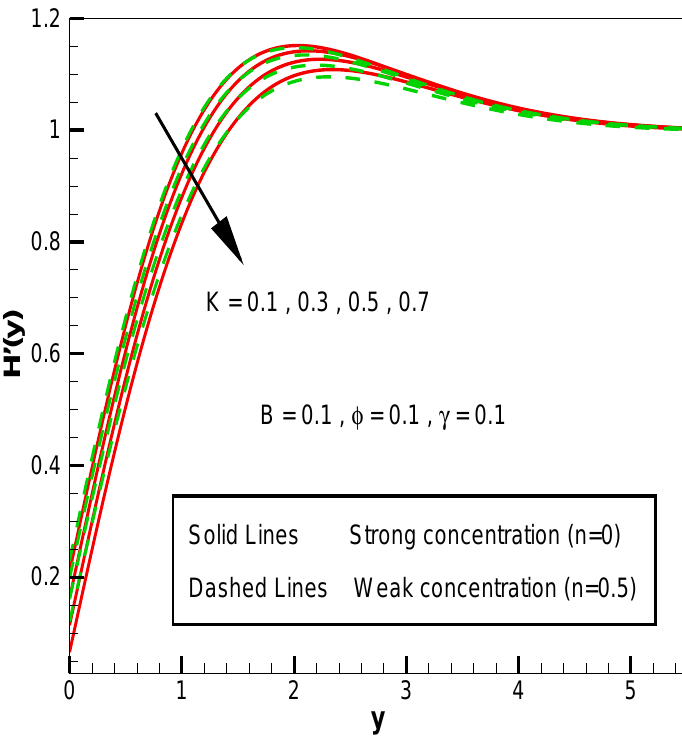
Figure 3. F (cid:48) ( y ) for volume fraction of nanoparticles φ . Figure 3. 𝐅 (cid:4593) (𝐲) for volume fraction of nanoparticles 𝛟 .